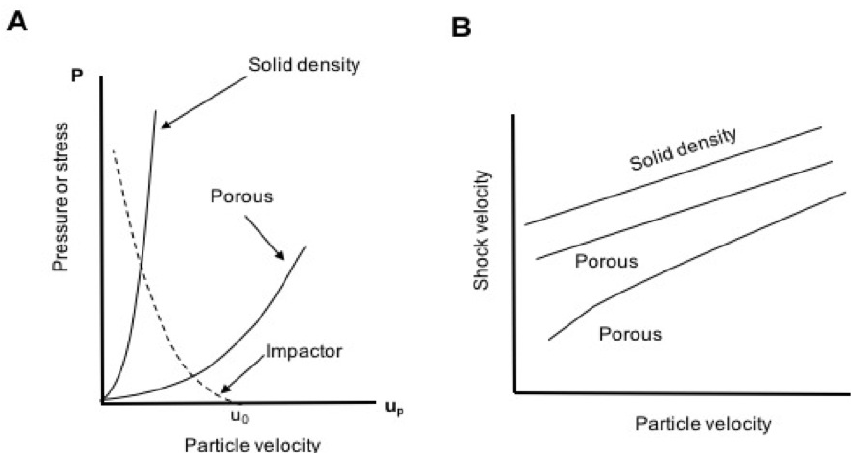
Figure 2. ( A ) Schematic Hugoniot curves for a solid material and its foam in the pressure-particle velocity ( P − u ) plane. The slope of the Rayleigh line connecting the origin to a point on either curve is ρ 0 U (see Equation (2)), also known as the shock impedance of the material; porosity lowers the impedance relative to that at full density. ( B ) The Hugoniot of many materials is linear in the shock velocity-particle velocity ( U − u ) plane. Porosity has the effect of lowering U at a given u , and can produce curvature at low u due to the enhanced compressibility associated with pores.